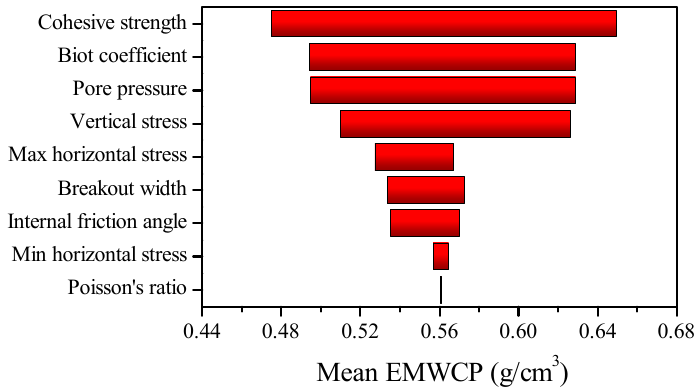
Figure 12. Sensitivity tornado for EMWCP.